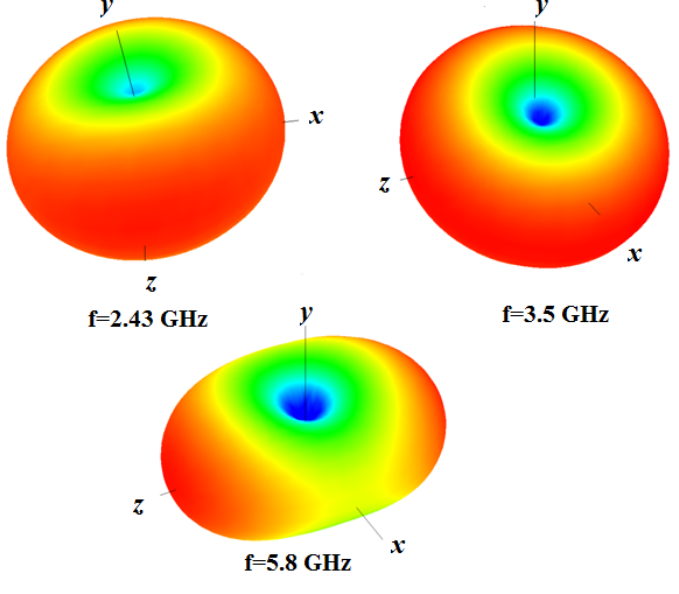
Figure 7: 3D Radiation patterns of the proposed tri-band antenna at different resonant